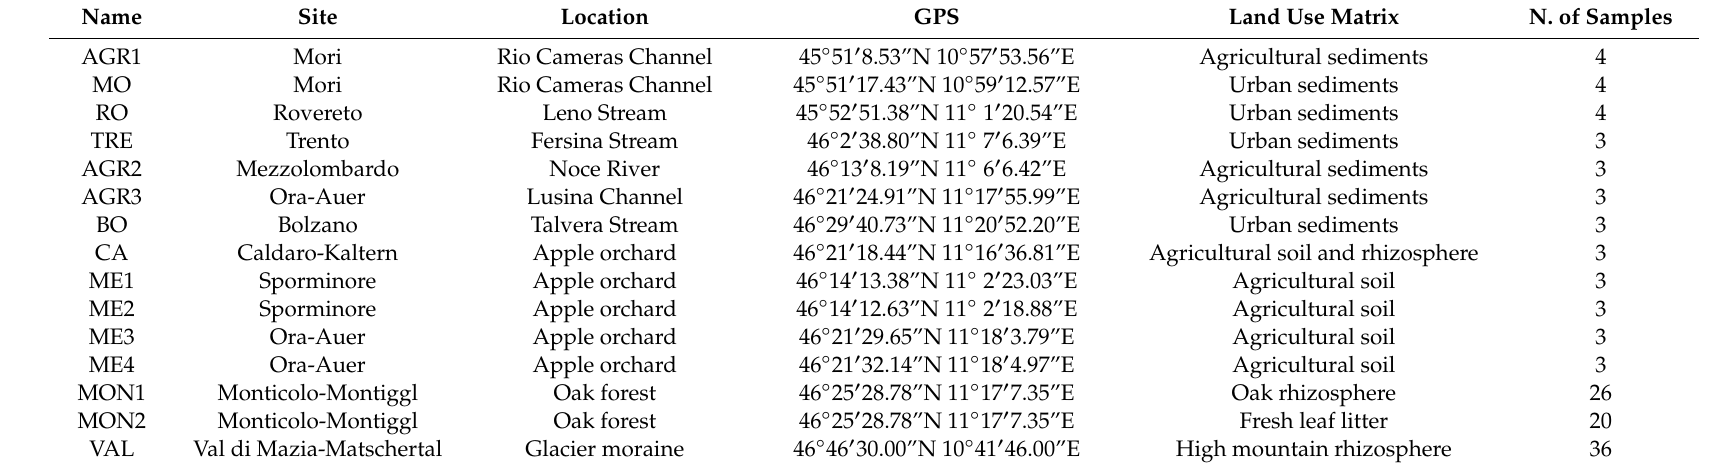
Table 1. Name of sites, location, GPS coordinates, land use matrix and number of samples collected per each